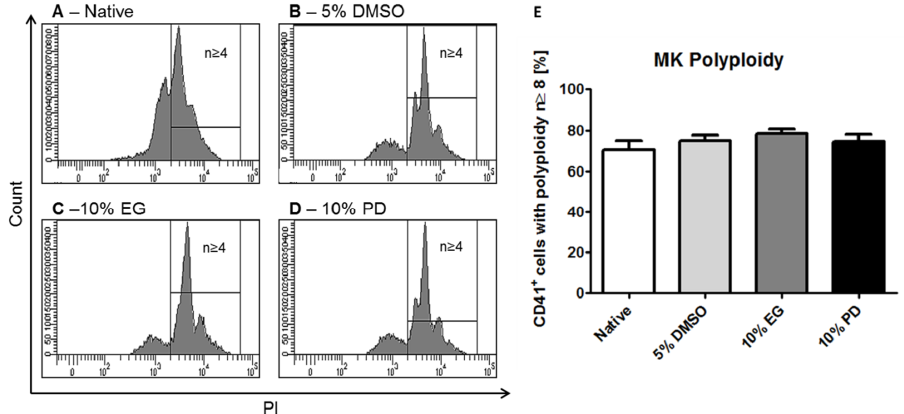
Figure 5. Polyploidy of in vitro iPSC-derived MKs before ( A ) and after (( B )—5% DMSO; ( C )—10% EG; ( D )—10% PD) cryopreservation. Propidium iodide staining analyzed with flow cytometry. MKs stained with anti-CD41 antibody. Representative histograms with gated ploidy n ≥ 4. ( E )—Percentage of MKs with ploidy n ≥ 4, represented as mean ±